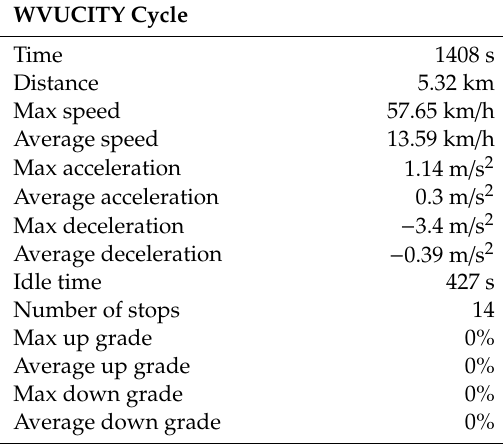
Figure 5. Speed profile (blue) and slope profile (green) extra-urban cycle.